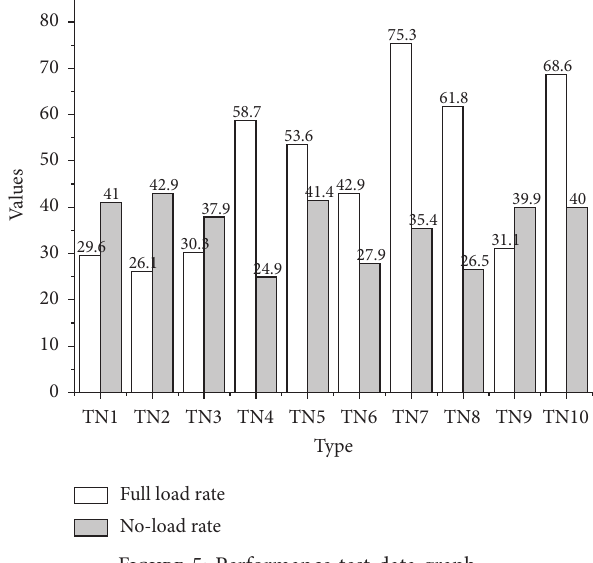
Figure 5: Performance test data